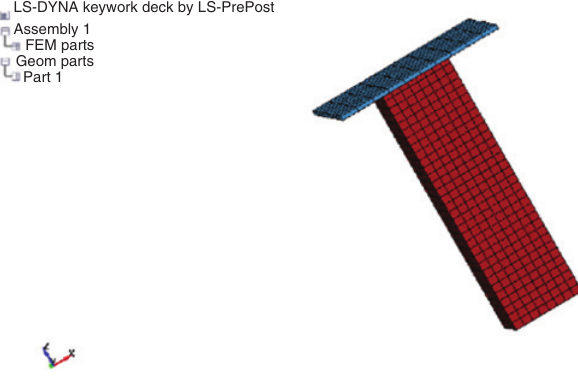
Figure 1 Finite element model of composite square